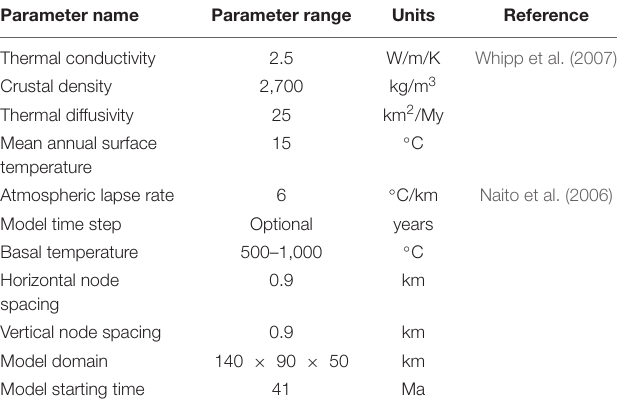
TABLE 2 | Thermokinematic and elastic parameters used in this